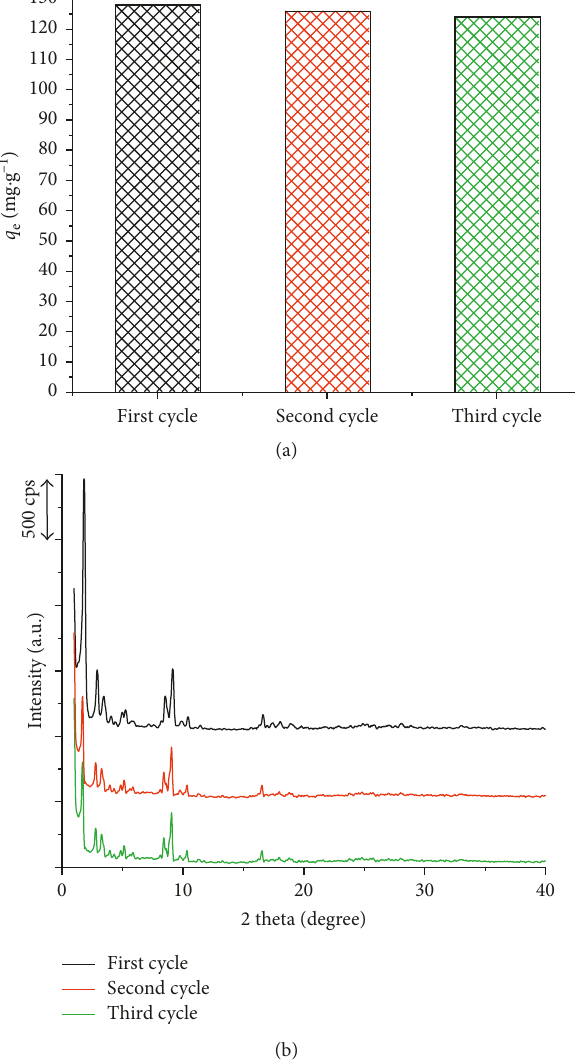
Figure 10: (a) Effect of regeneration cycles of ZIF-67 adsorbents on the adsorption of RDB; (b) the XRD patterns of ZIF-67 after three 1 , m cycles ( V 100mL; C RDB 100mg L MIL-101 / V RDB (cid:30) 0.1g/100mL; (cid:30) (cid:30) · shaking time 12 − (cid:30)